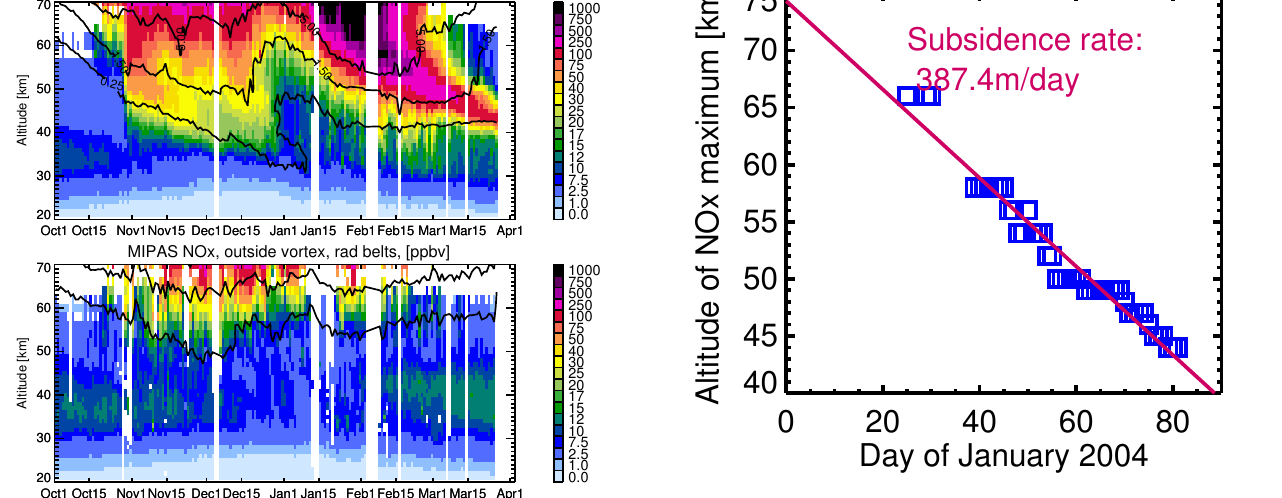
Figure 4. Blue squares: temporal evolution of the peak altitude of NO x as observed in MIPAS observations inside the polar vor- Fig. 4. Blue squares: temporal evolution of the peak altitude of NOx as observed in MIPAS observations inside the polar vortex (equivalent Figure 3. Top panel: as Fig. 2, but for NO x (NO + NO 2 ). Lower tex (equivalent latitudes polewards of 65 ◦ N), from January through Fig. 3. Top panel: as Fig. 2, but for NOx (NO+NO 2 ). Lower panel: as upper panel, but outside the polar vortex (equivalent latitudes ≤ 55 ◦ ), latitudes polewards of 65 ◦ N), from January through March 2004. The red line is the result of a least-square fit to those observations, giving panel: as upper panel, but outside the polar vortex (equivalent lat- March 2004. The red line is the result of a least-square fit to those and sampled only in the radiation belt region (geomagnetic latitudes of 55 ◦ –68 ◦ ). Bold lines are CO isolines of 0.25, 1.5 and 5.0ppmv an average subsidence rate of 400 m/day for the NOx maximum. itudes ≤ 55 ◦ ), and sampled only in the radiation belt region (geo- observations, giving an average subsidence rate of 400mday − 1 for sampled in the same way as indicators of vertical transport and vortex origin. magnetic latitudes of 55–68 ◦ ). Bold lines are CO isolines of 0.25, the NO x maximum. 1.5 and 5.0ppmv sampled in the same way as indicators of vertical transport and vortex origin.